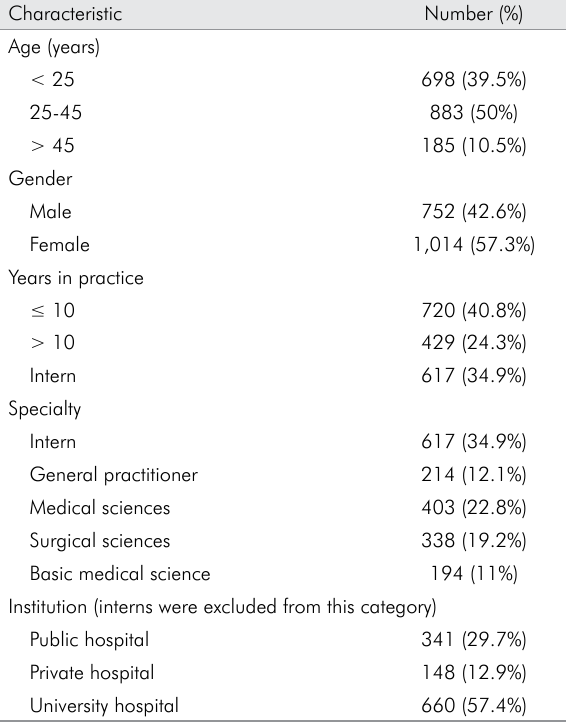
Table 1. Demographic data for the [1,766] medical doctors who responded to the questionnaire.